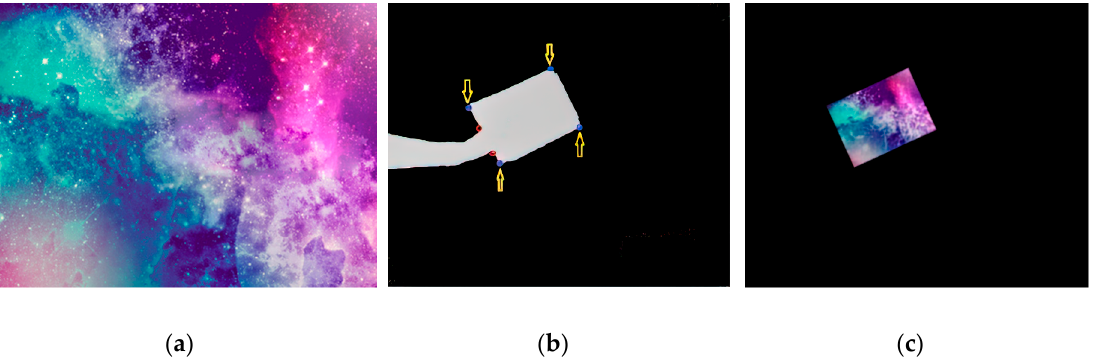
Figure 6. ( a ) Image to be fitted, ( b ) corners of the plane to which the image should be fitted, ( c ) fitting of the image to the plane.